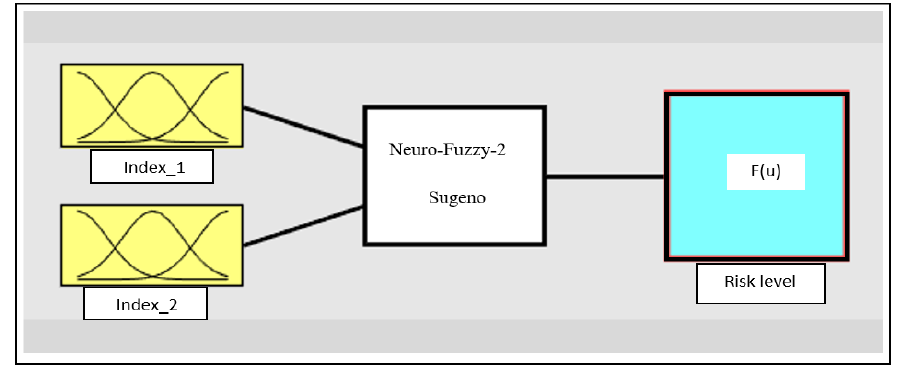
Figure 13. Using the Sugeno-type FIS method in the proposed method.